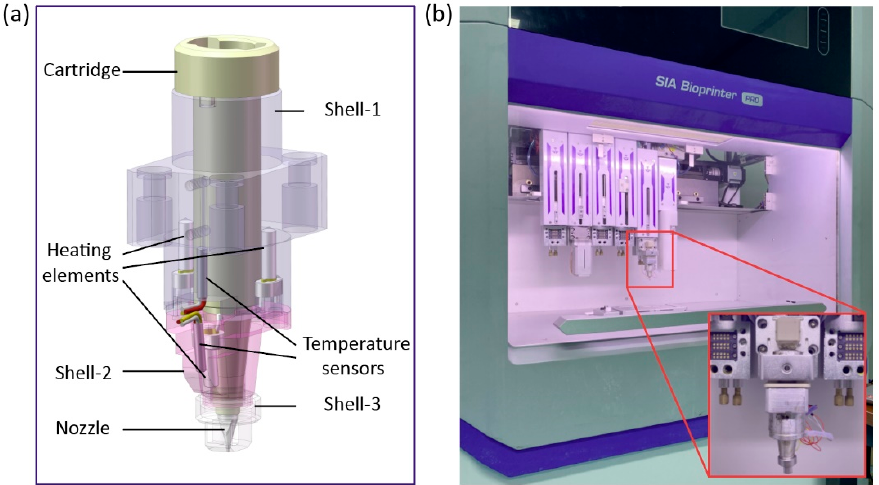
Figure 1. Configuration of the 3D printing device. ( a ) Configuration of the proposed print head; ( b ) A self-developed high-precision 3D bioprinter. ( b ) A self-developed high-precision 3D